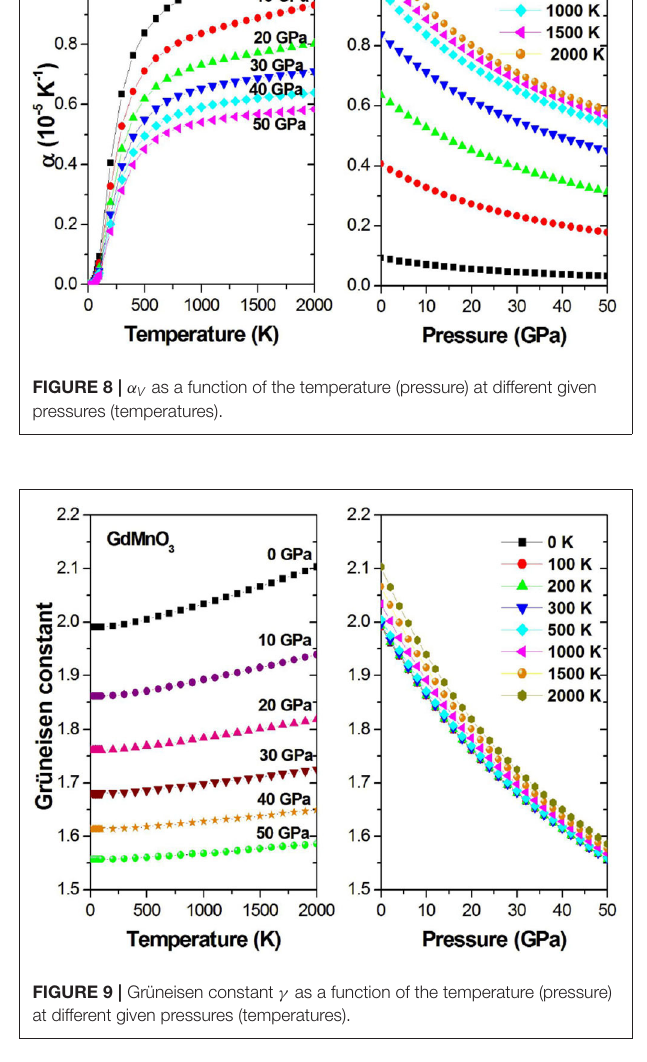
pressure will only increase the initial value of α V without affecting the trend.